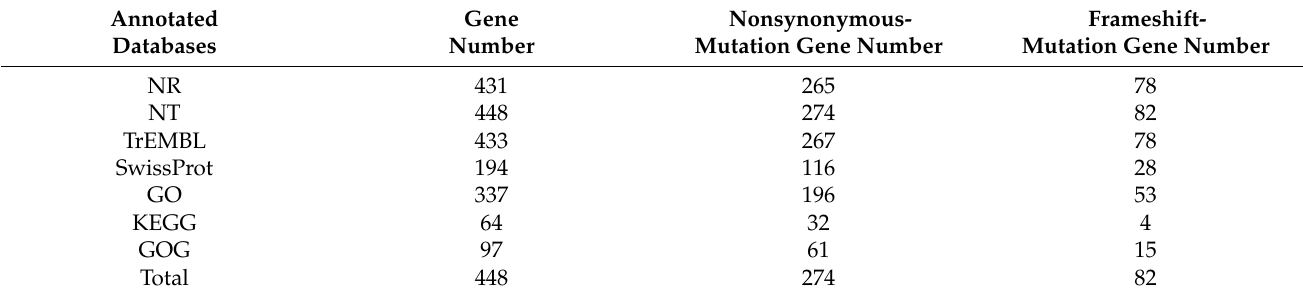
Table 3. Information of annotated genes in the identified regions using multiple databases.